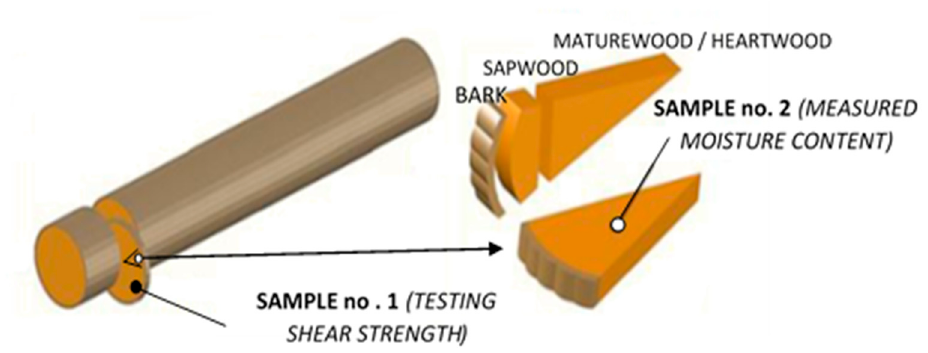
Figure 1. Schematic representation of sampling from stored logs .